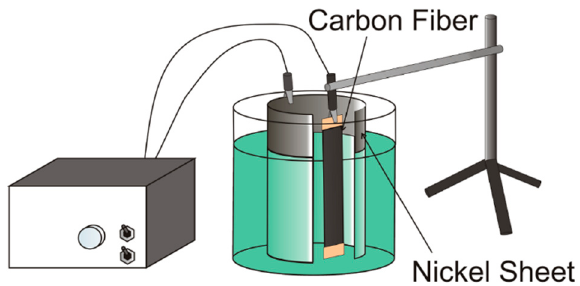
Figure 2. Schematic drawing of Ni plating method.